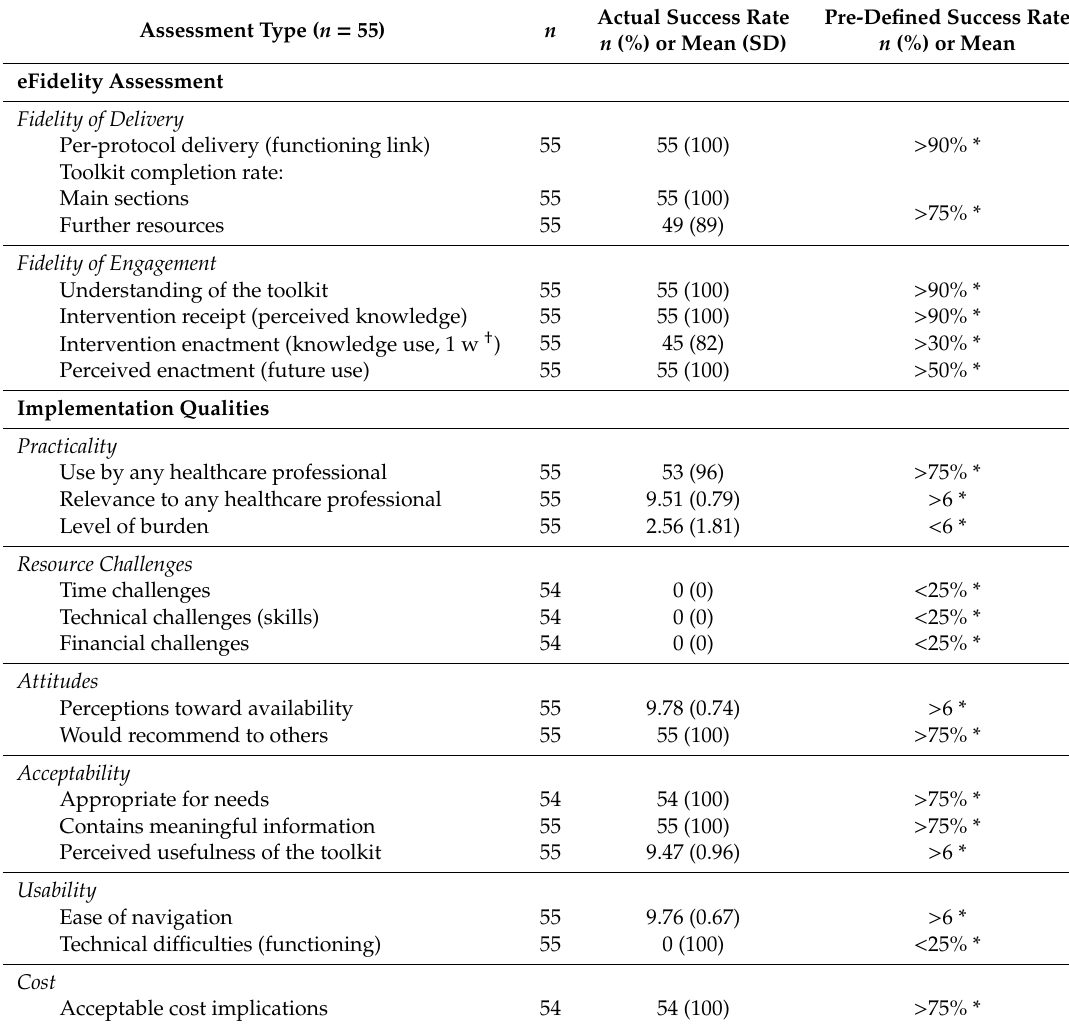
Table 3. Intervention Fidelity and Implementation